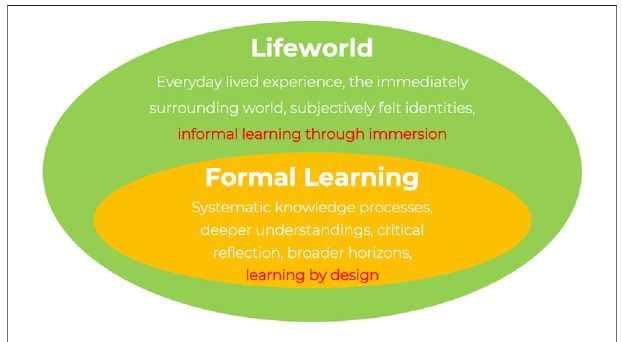
FIGURE 1 | The lifeworld contexts of